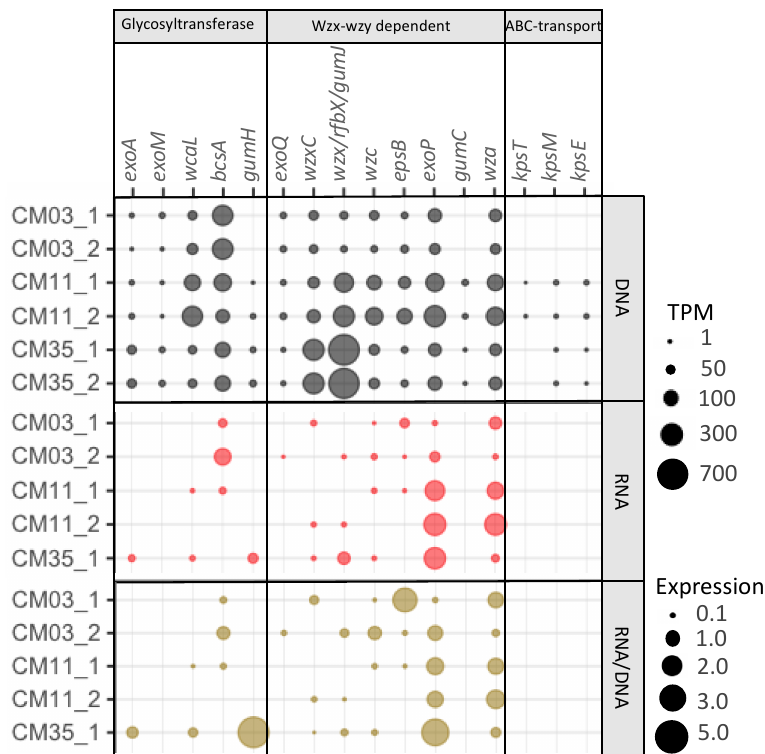
Figure 4. Normalized gene abundance (upper rows), normalized transcript abundance (middle row), and expression (lower rows) of extracellular sequestration genes detected in the co-assembled metagenomes from the three layers of Cueva de la Mora (CM). Normalized gene and transcript abundances are calculated as TPM values. Expression is calculated as transcript TPM/gene TPM. All of these genes are involved in biosynthesis of polysaccharides (glycosyltransferases), and polysaccharide assembly and transport (Wzx-wzy dependent pathway and ABC transport). 1 and 2 refers to replicates (DNA or mRNA reads from each replicate mapped to co-assembled metagenomes). Gene functions and their respective KOs are listed in Table 4. mRNA reads from CM35_2 are not included due to low mapping rates to the co-assembled metagenome.